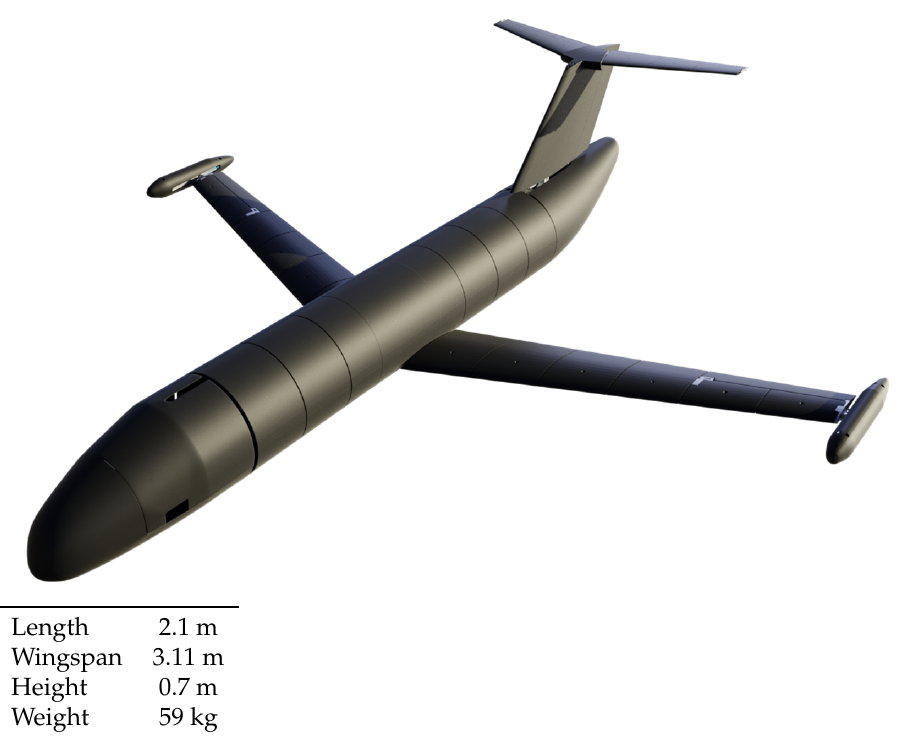
Figure 1. X–Dia configuration used during the wind tunnel